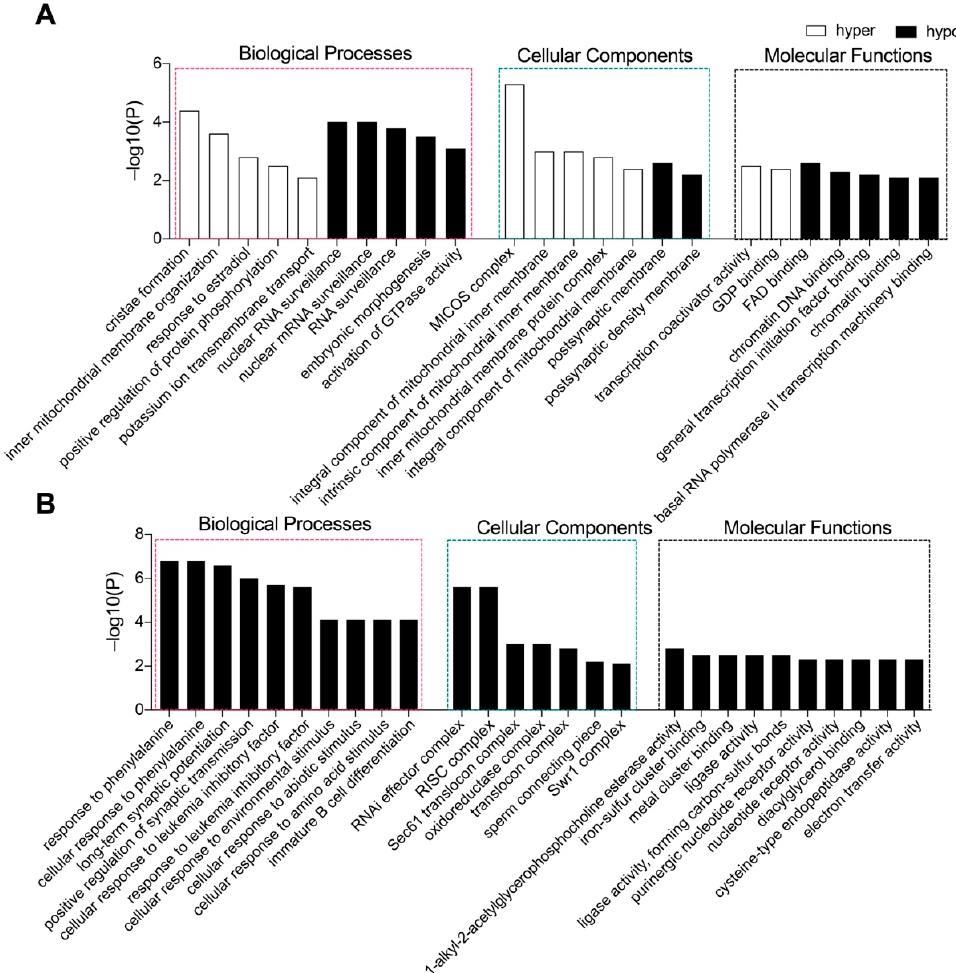
Figure 5. Genes with promoter methylation altered by the action of Tet1 and Tet2. ( A , B ) GO-term enrichment analysis of functions of genes with hypomethylated promoters caused by Tet1 ( A ) or Tet2 ( B ). The genes were enriched with criteria at − lg ( p − value), p − value < 0.01.